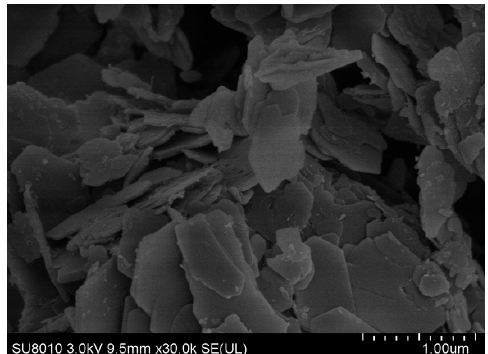
Figure 2. SEM image of layered double hydroxides (LDHs). Materials 2019 , 12 , x FOR PEER REVIEW